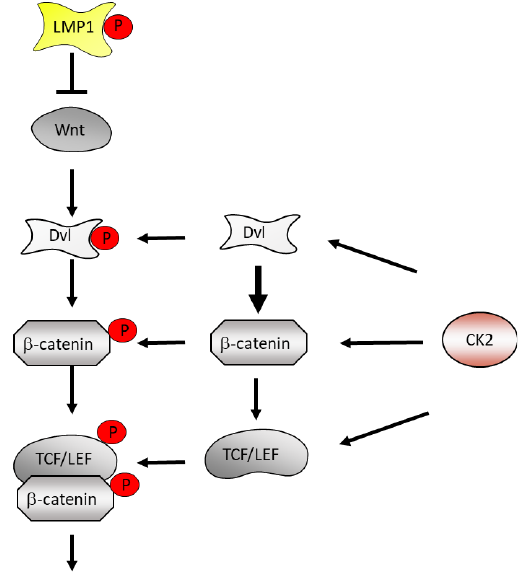
Figure 3. LMP1 and CK2 cooperate in the activation of the Wnt, Dishevelled and β -catenin pathway. CK2 phosphorylates and activates Wnt, Dishevelled and β -catenin to promote cell proliferation and a reduction in apoptosis.